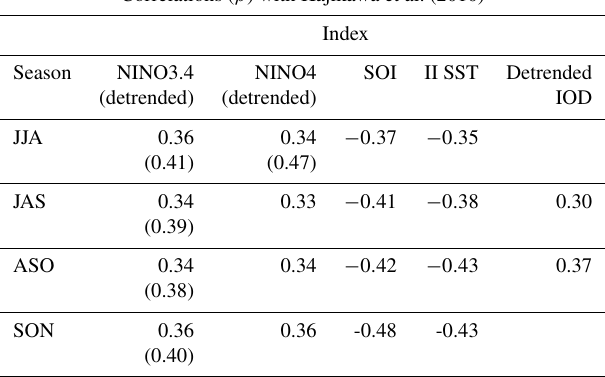
Table 4. Correlation coefficients of seasonal climate indices with Kajikawa et al. (2010) monsoon onset dates. Only | ρ | > 0 . 3 and p< 0 . 05 are